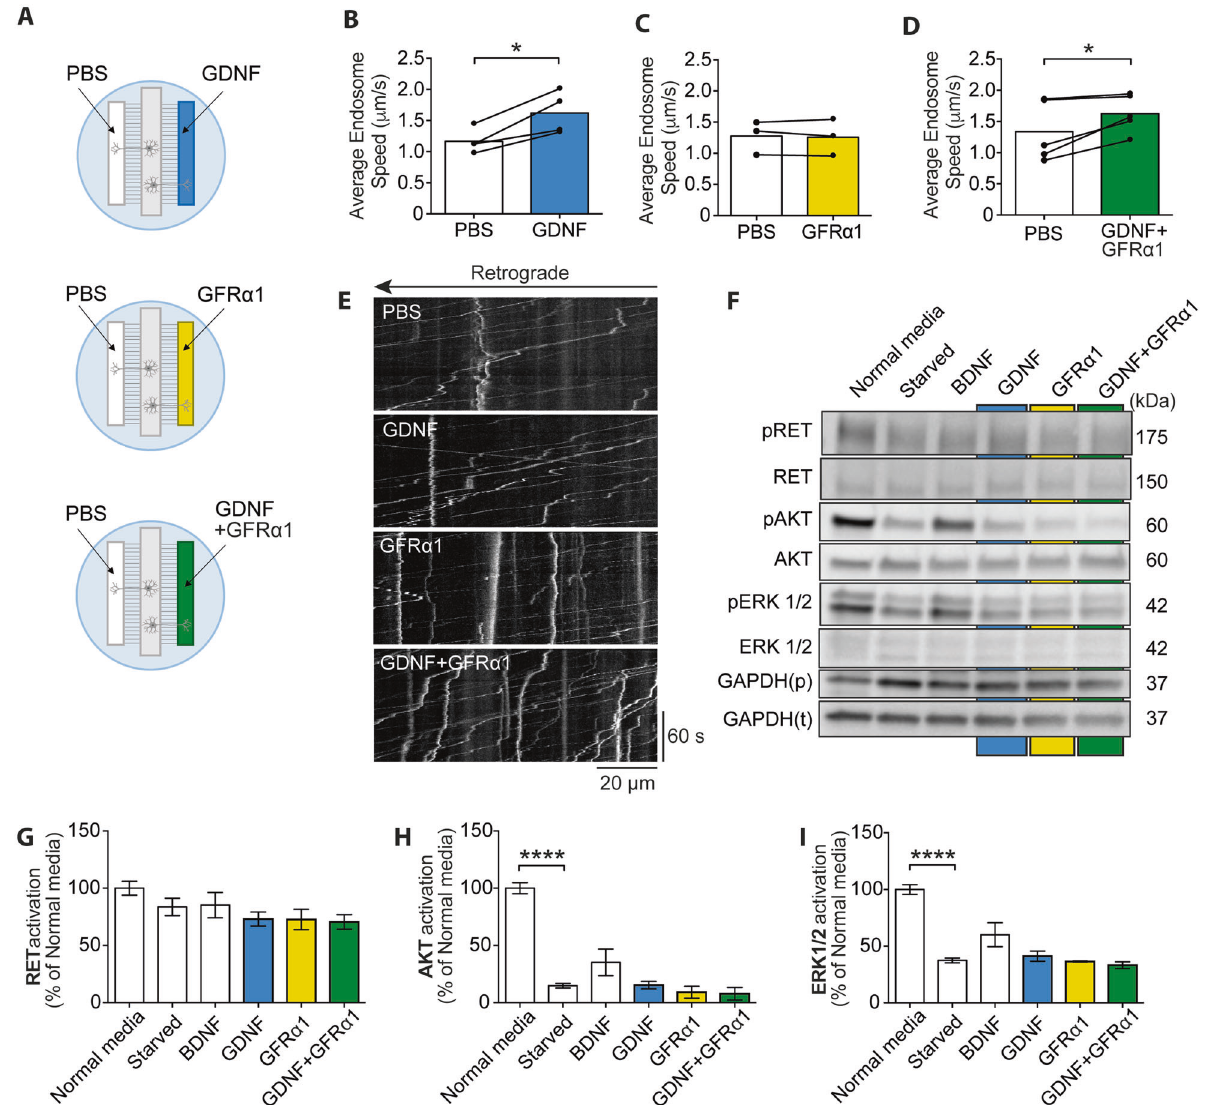
Fig. 3 Stimulation with GDNF enhances WT axonal transport. A Schematic representation of GDNF and GFR α 1 transport experiments in three-compartment MFCs. Primary ventral horn neurons were cultured in the central (somatic) compartment of 3-channel MFCs, with axons projecting to two lateral fl uidically isolated axonal chambers. 100 ng/ml GDNF, GFR α 1, or both together were added to one axonal compartment, with PBS added to the other as an internal control. B – D Average endosome speeds following the addition of GDNF ( B ), GFR α 1 ( C ), and GDNF + GFR α 1 ( D ) in the right compartment and PBS in the left compartment ( B – D ). Each point represents a biological replicate. Connecting lines represent speeds observed in control and experimental condition-treated axons from the same cultures. Speeds were signi fi cantly increased with GDNF alone (* p = 0.02) and GDNF with GFR α 1 (* p = 0.04), but not GFR α 1 alone ( p = 0.6799), as determined by two- tailed paired t tests. E Representative kymographs showing signalling endosome transport in axons of WT primary MN cultures following treatment with PBS, GDNF, GFR α 1 or GDNF together with GFR α 1. N = 3 – 5 biological replicates. Bars represent mean ± SEM. PBS results were collected from 443 endosomes in 42 videos for a total of 45 569 single movements ( n = 5). GDNF results were collected from 218 endosomes in 22 videos for a total of 17 938 single movements ( n = 4). GFR α 1 results were obtained from 216 endosomes in 24 videos for a total of 21 981 single movements ( n = 3). GDNF and GFR α 1 results were collected from 400 endosomes in 29 axons for a total of 31 809 single movements ( n = 5). F Representative western blot of primary MN lysates following starvation in Neurobasal and Glutamax, and treatment with 50 ng/ml BDNF, or 100 ng/ml GDNF, and GDNF and GFR α 1 (both 100 ng/ml). G – I Western blot quanti fi cation of RET, AKT and ERK1/2 activation after starvation and stimulation with BDNF, GDNF and GFR α 1. Starvation signi fi cantly decreased activation of AKT (**** p < 0.0001) and ERK (**** p < 0.0001), but not RET (one-way ANOVA with Dunnett ’ s multiple comparison administered at both 10 mg/kg and 100 mg/kg signi fi cantly 25 ng BDNF were injected into the tibialis anterior and gastro- enhanced signalling endosome transport in SOD1 G93A mice cnemius muscles in the lower limb of anaesthetised female WT and SOD1 G93A mice. For in vivo delivery, we suspended C3 in 1% in vivo [4]. Approximately 4 hours after injection of H C T-555, mice methyl cellulose (MC) and injected it intraperitoneally at a fi nal were re-anaesthetised and the sciatic nerve of the injected limb concentration of 10 mg/kg. Since no pharmacokinetic or pharma- was exposed for intravital imaging. codynamic data for C3 is currently available, we selected 10 mg/kg Stills from representative transport videos are shown in Fig. 6A. In based on previous fi ndings showing that two p38MAPK inhibitors SOD1 G93A mice treated with vehicle (1% MC in PBS), we observed the